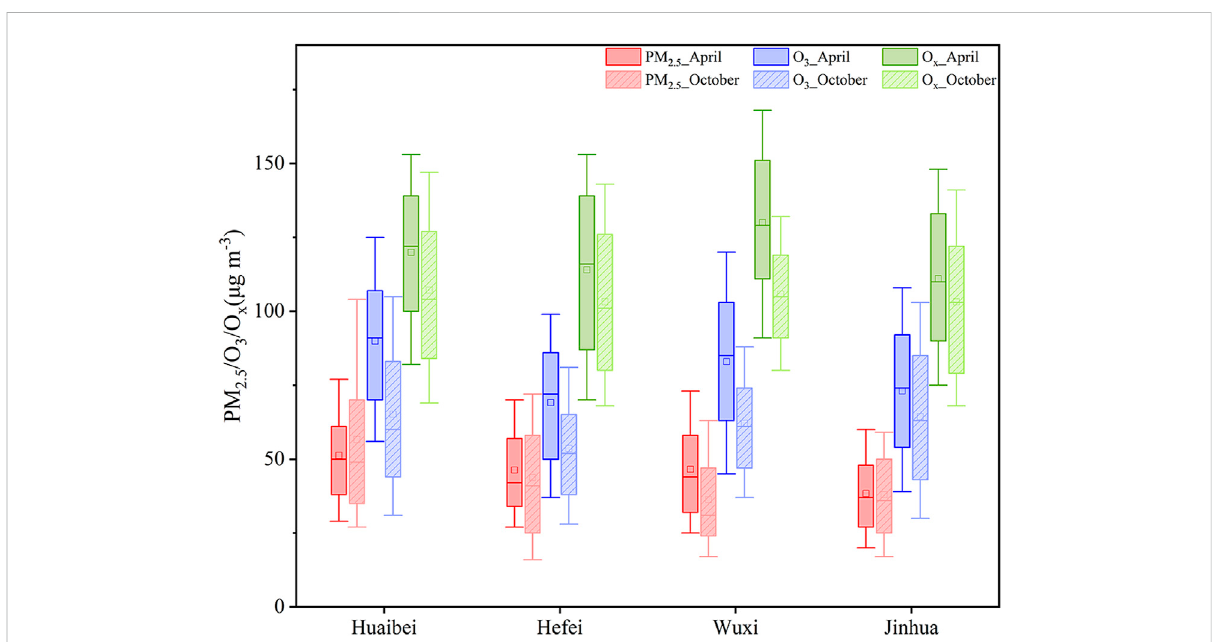
FIGURE 6 PM 2.5 ,O 3 ,andO X (=O 3 +NO 2 )concentrationsofHuaibei,Hefei,Wuxi,andJinhuacitiesinAprilandOctoberfrom2015through2021.Theupper and lower boundaries of the box represent the 75th and 25th percentiles, respectively. The short line within the box represents the median. The whiskers represent the 10th and 90th percentiles. The square represents the